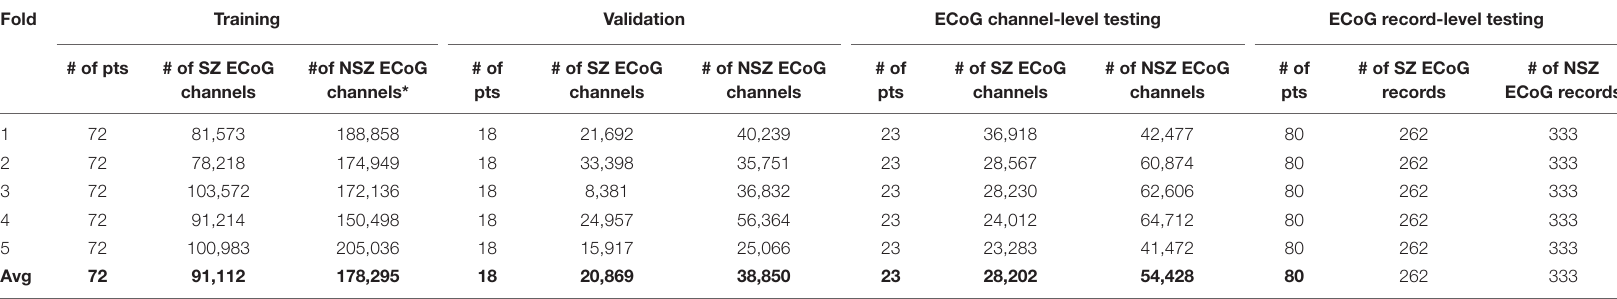
TABLE 1A | Number of patients, seizure and non-seizure ECoG channels in the training, validation and test datasets in each fold (and average across the 5 folds) for testing ECoG channel-level and ECoG record-level classification performances. Fold Training Validation